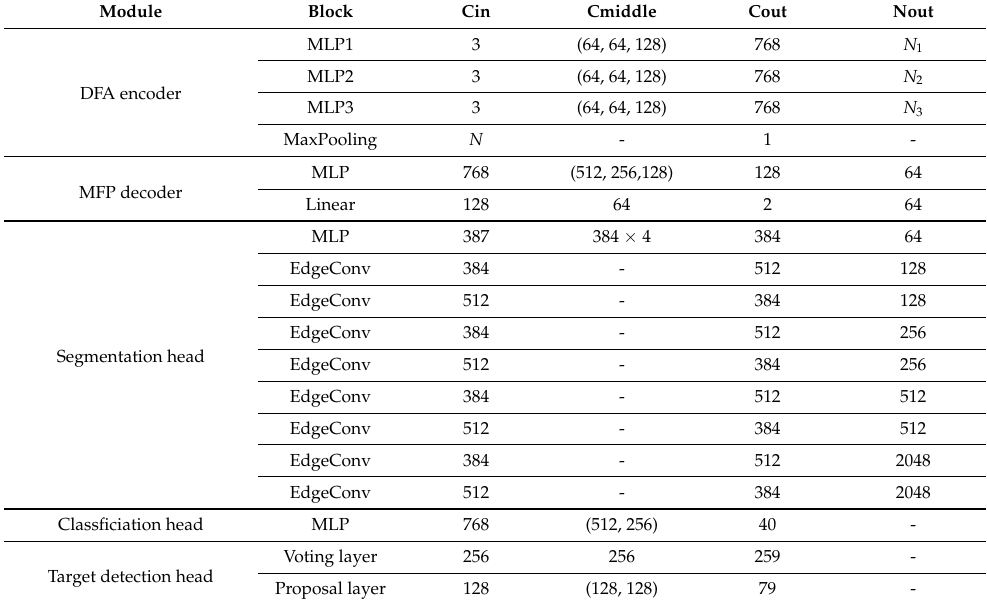
Table 15. Network architecture details. N 1 , N 2 , and N 3 denote the number of boundary points, cross points, interior points and N 1 + N 2 + N 3 = N